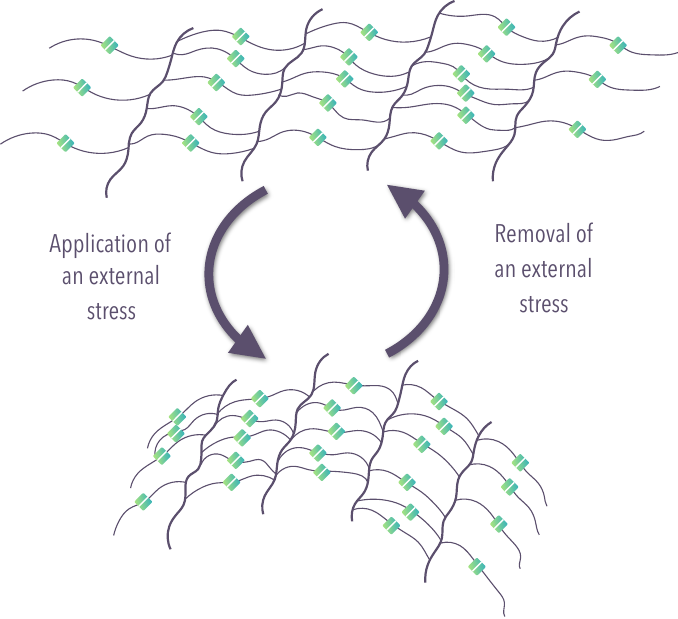
Figure 2. Schematic representation of the molecular mechanism of shape-changing material (SCM) (modified from Iqbal et al.